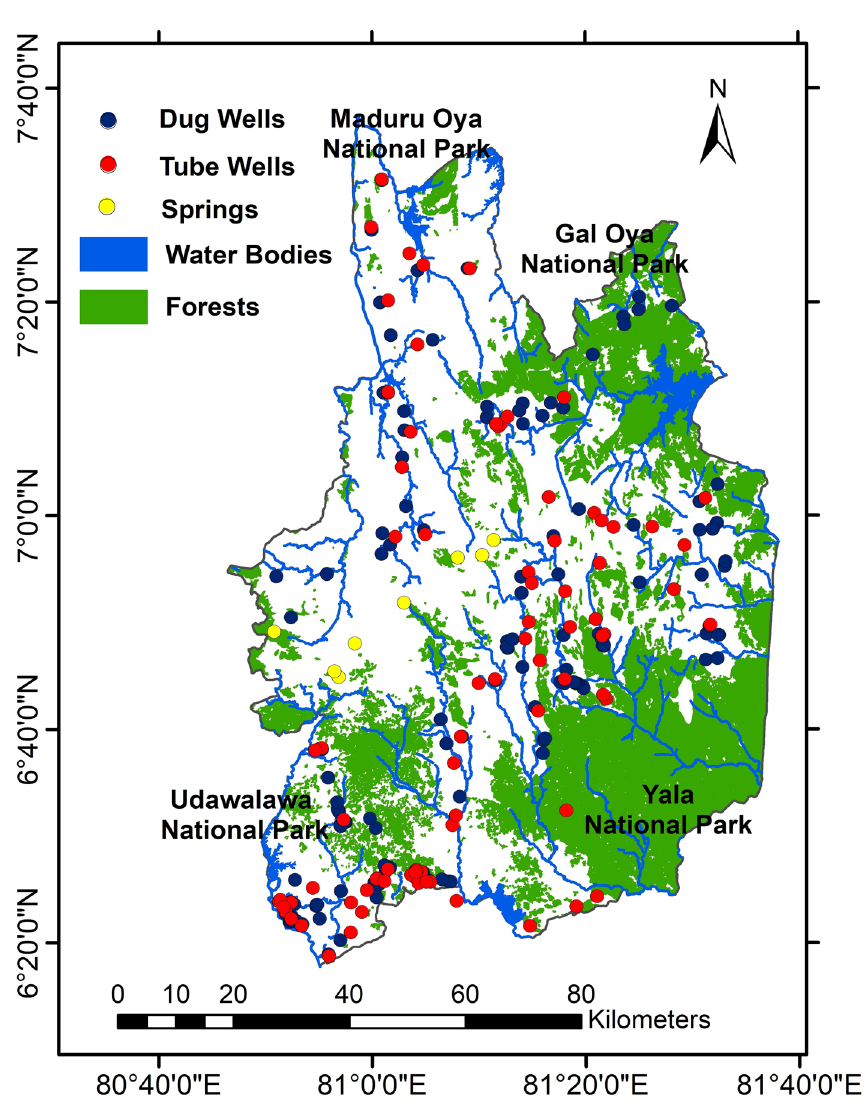
Fig. 2 Map showing the sam- pling locations of the